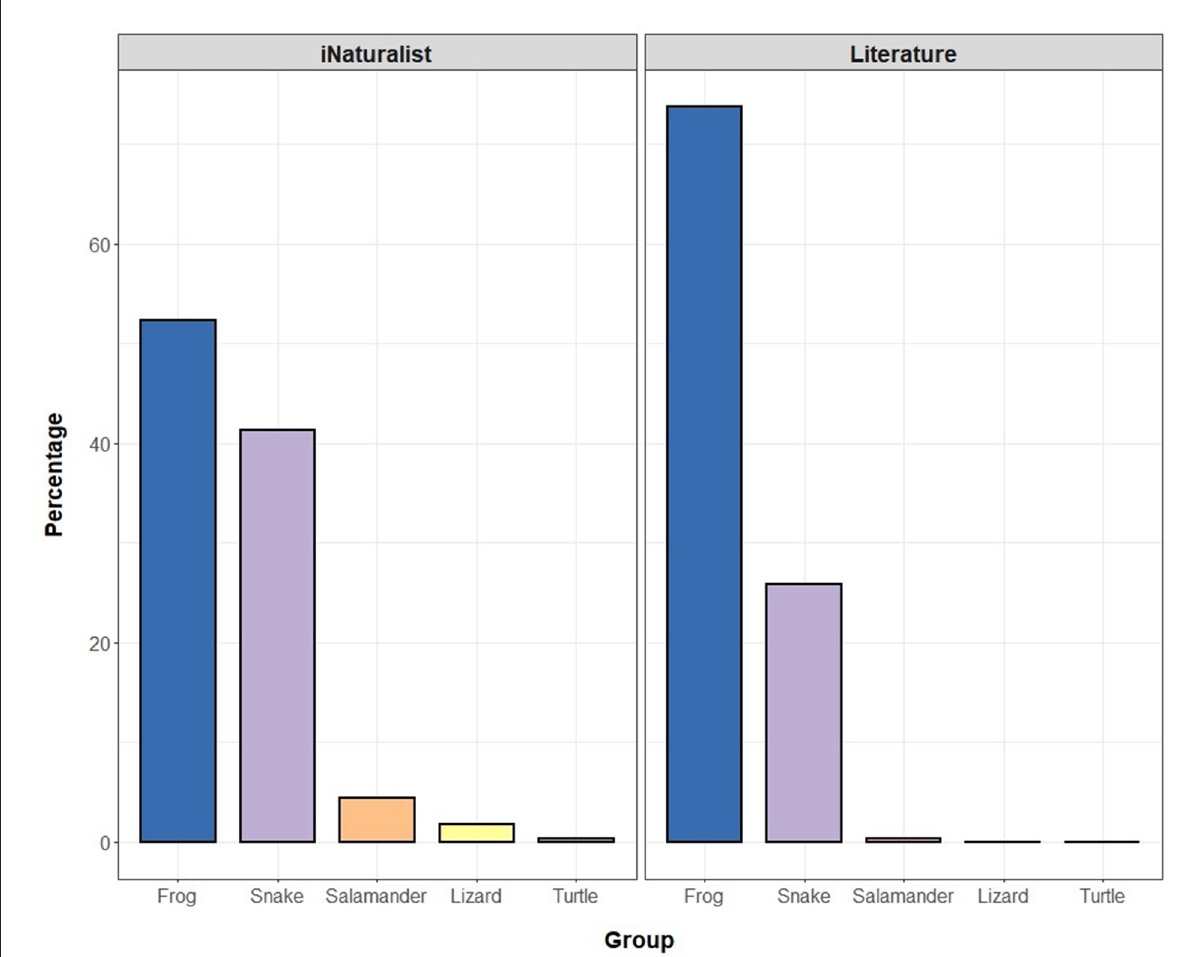
FIGURE3 Taxonomic sampling of roadkill records according to the citizen science (iNaturalist) and literature data. The overall taxonomic representation, expressed as percentages was similar between the datasets, despite the much larger total sample size of the literature data. The anuran amphibians showed the highest roadkill frequency (iNaturalist: n n 2,750), salamanders (iNaturalist: n = literature: